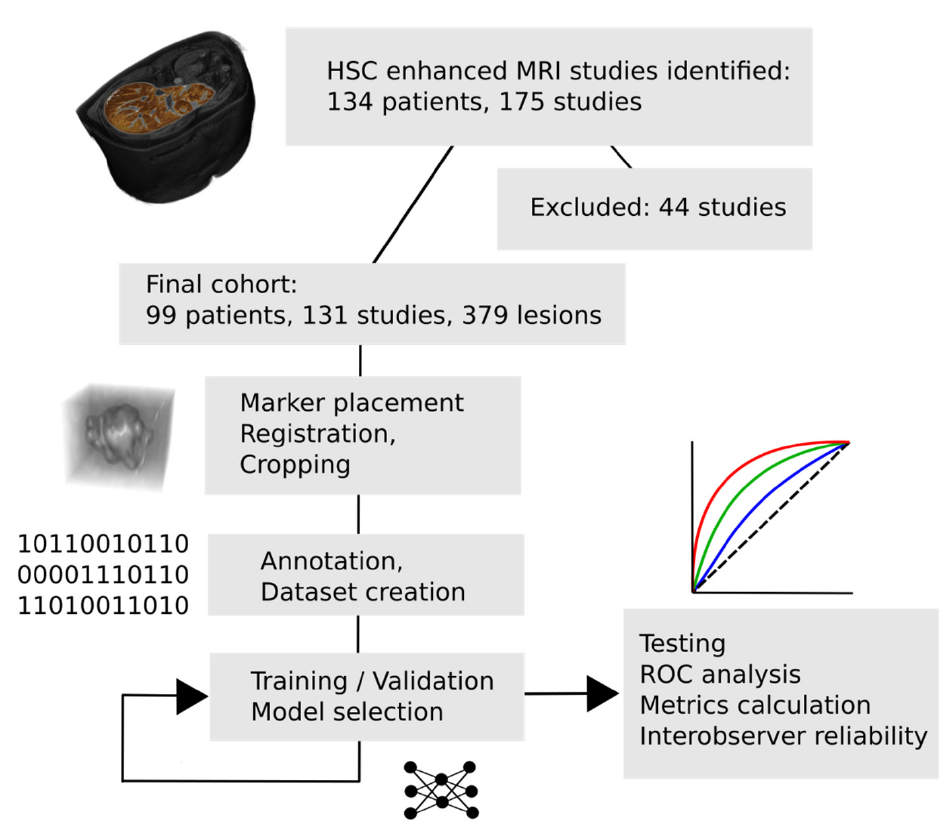
Figure 1. Main steps of the study. After the selection of analyzable examinations, each was annotated and preprocessed, and the marked lesions were cropped for training. The trained model was evaluated on a separate test dataset. HSC = hepatocyte-specific contrast-enhanced, MRI = magnetic resonance